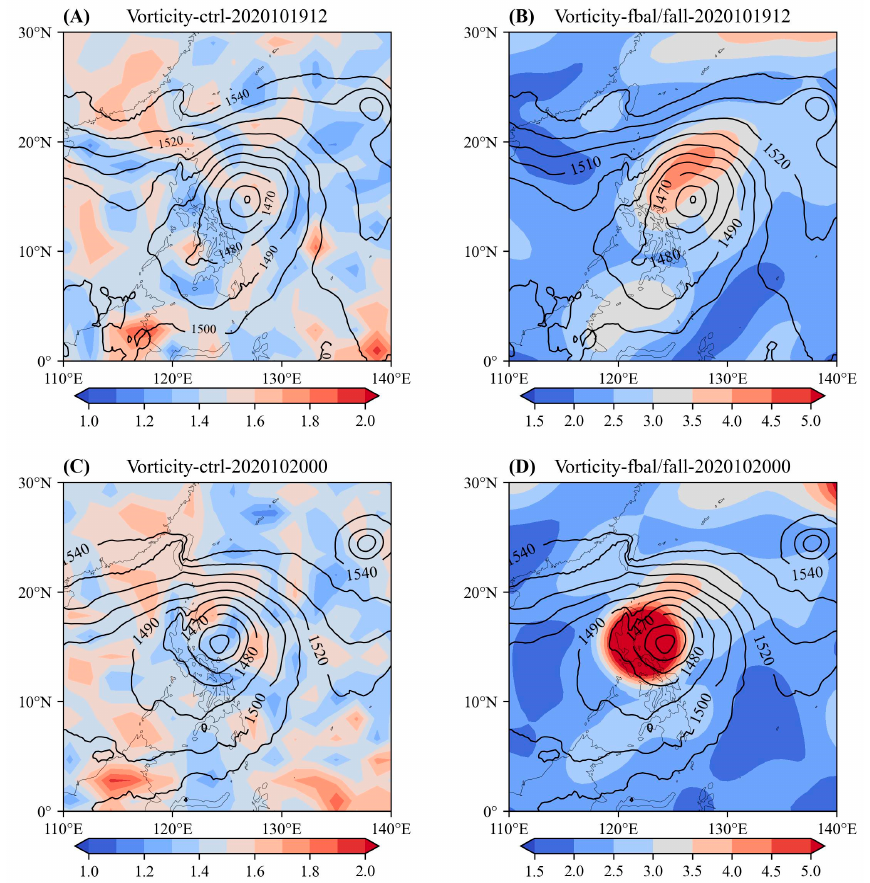
Figure 1. Standard deviations of vorticity at model level 114 (~850 hPa) at times 1200 UTC 19 October 2020 (top panel) and 0000 UTC 20 October 2020 (bottom panel). The left column ( A , C ) refers to the control experiment, and the right column ( B , D ) refers to the flow-dependent experiment. Unit: 10 − 5 s − 1 . The corresponding 850 hPa geopotential height analysis is overlaid, contour: 10